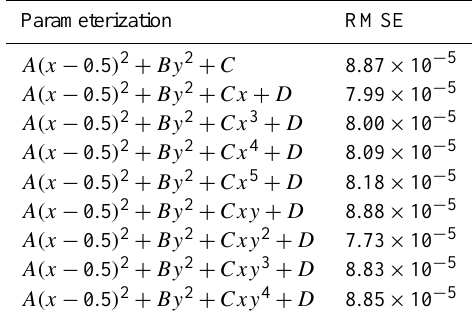
Table 1. Summary of different parameterizations and their